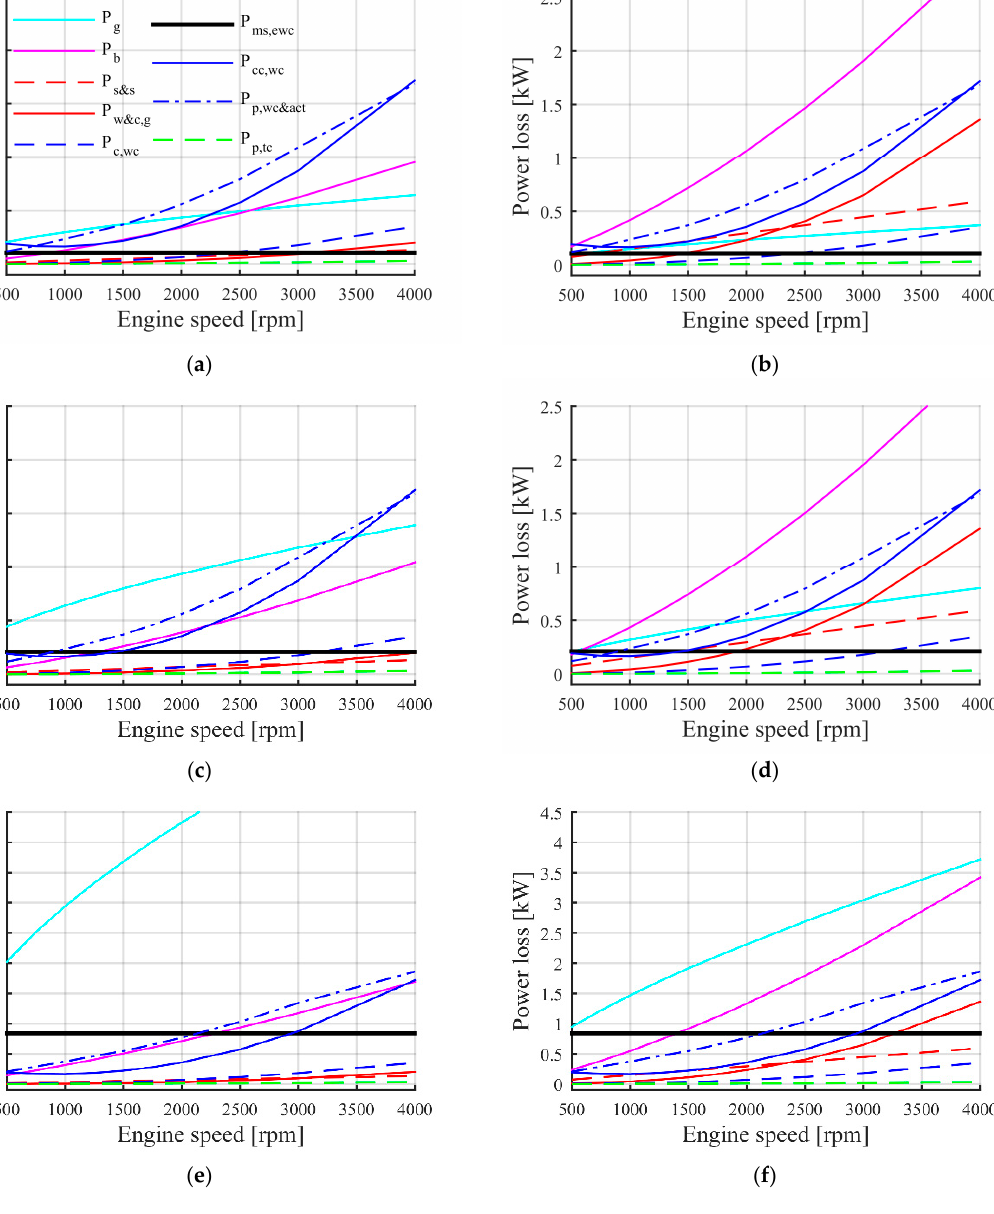
Figure 4. DCT power loss contributions at θ tr = 80 ◦ C: ( a ) T in = 50 Nm, first gear; ( b ) T in = 50 Nm, seventh gear; ( c ) T in = 100 Nm, first gear; ( d ) T in = 100 Nm, seventh gear; ( e ) T in = 400 Nm, first gear; ( f ) T in = 400 Nm, seventh